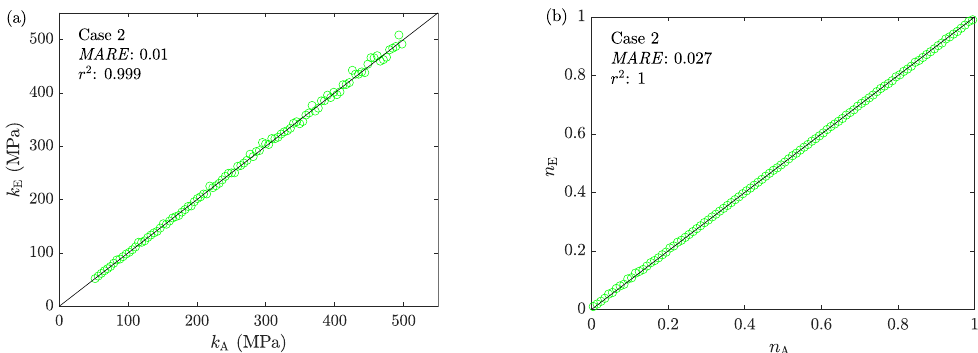
Figure 12. The correlation between the assigned and estimated values of the material parameters ( a ) k and ( b ) n for Case 2.